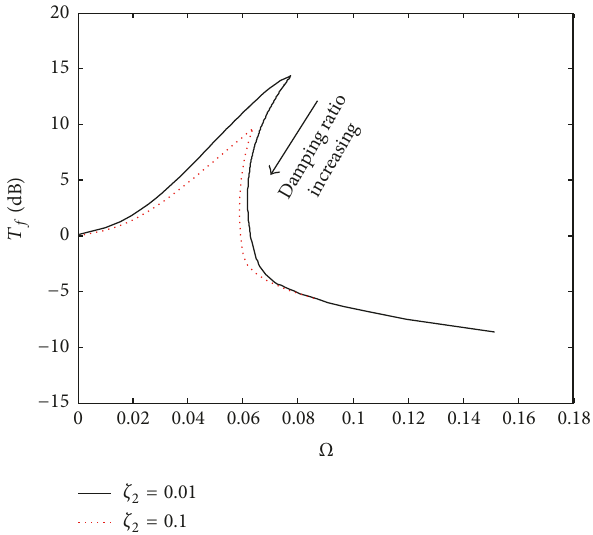
Figure 10: Force transmissibility for various 𝜁 2 .